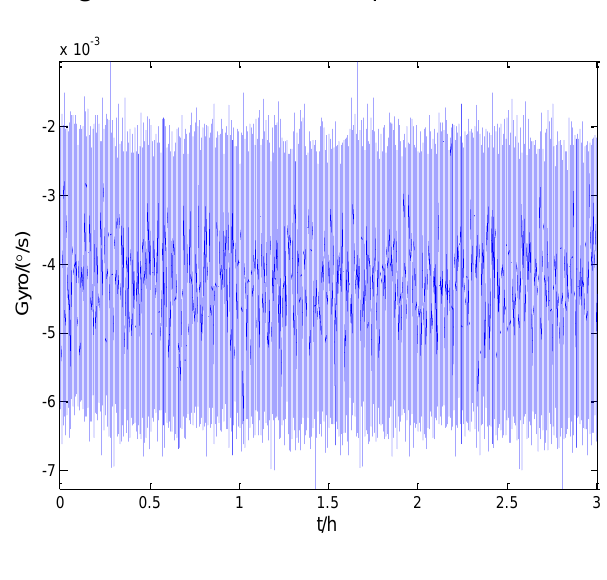
Figure 20. Allan variance plot of #1 FOG.